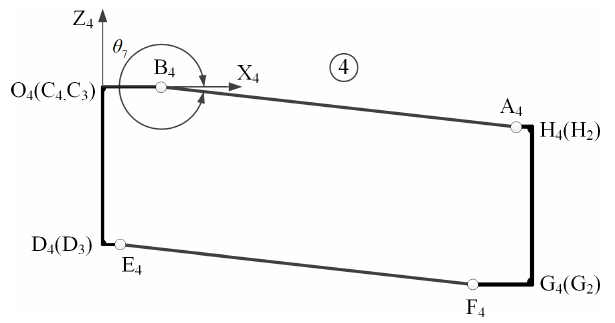
Figure 14. Planar rib mechanism (cid:195) .